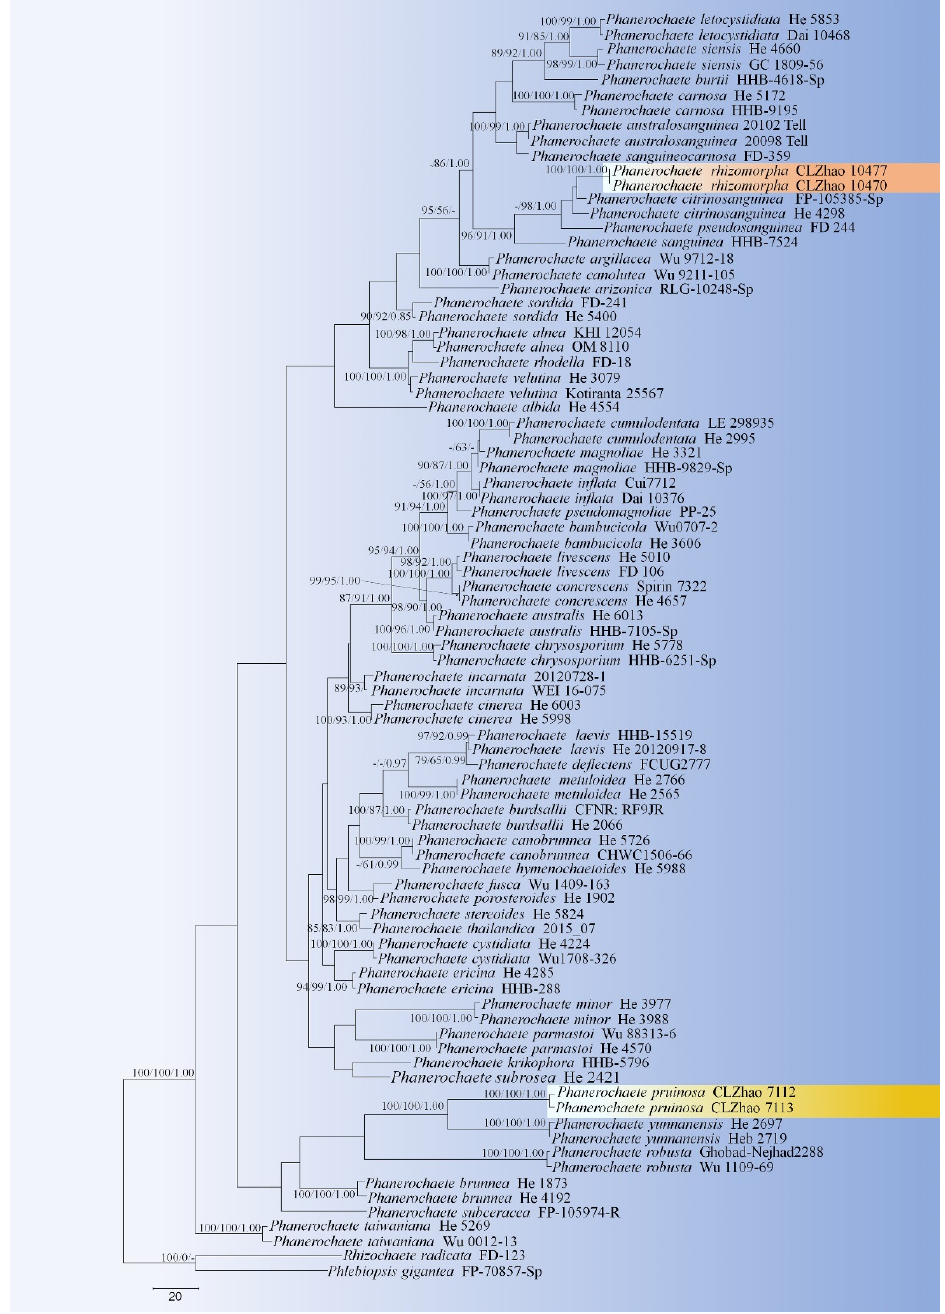
Figure 2. Maximum Parsimony strict consensus tree illustrating the phylogeny of two new species and related species in Phanerochaete based on ITS+nLSU sequences. Branches are labeled with maximum likelihood bootstrap values > 70%, parsimony bootstrap values > 70% and Bayesian posterior probabilities > 0.95, respectively. The yellow backgrounds indicate new species.